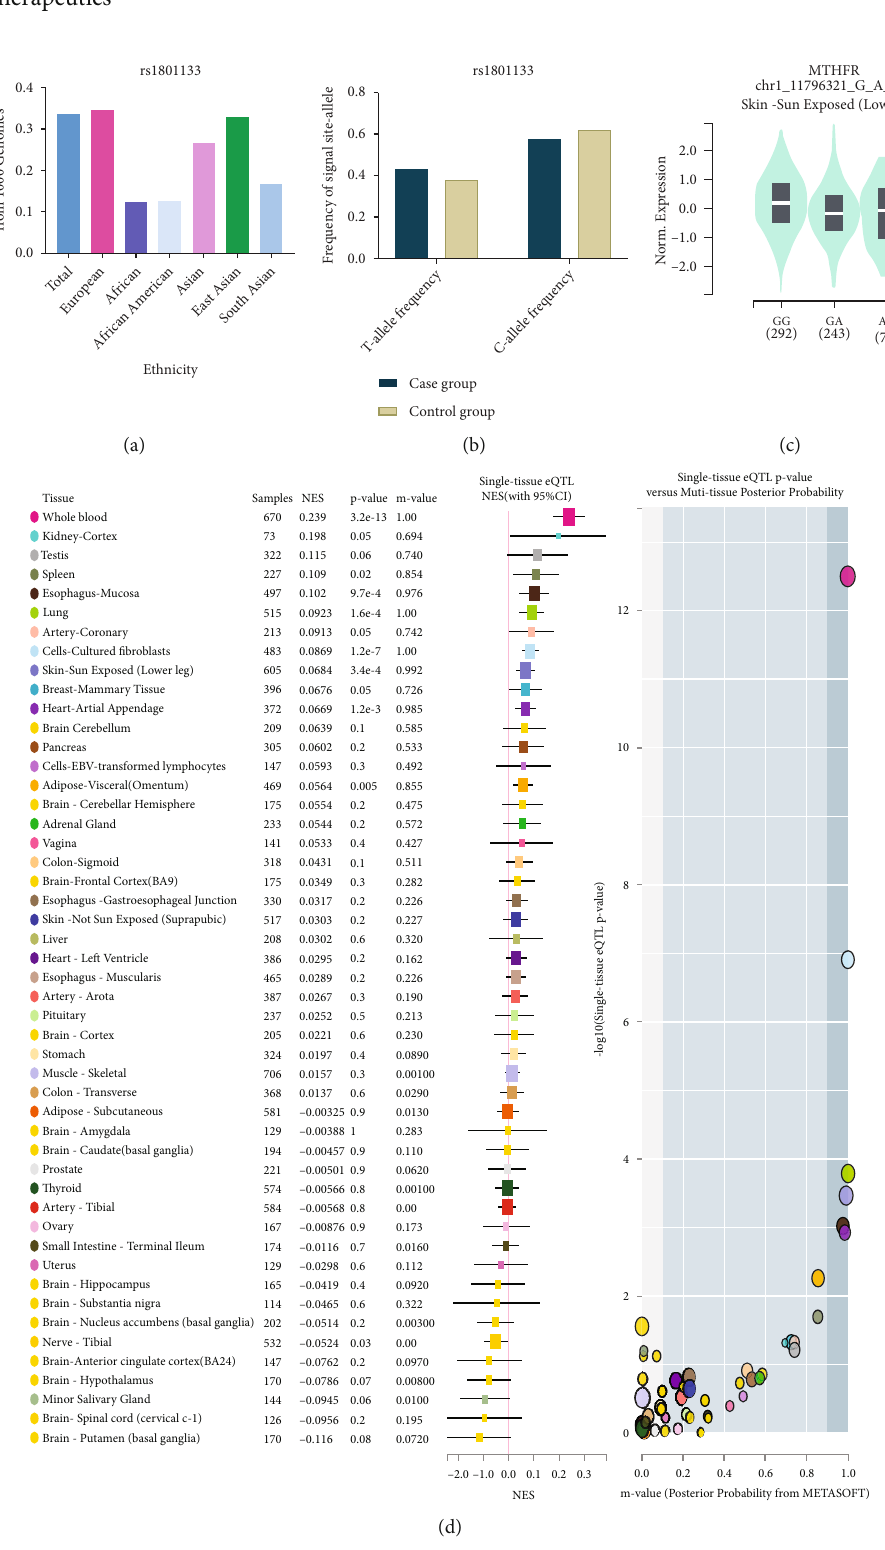
Figure 2: (a) The MAF of minor allele (mutant allele) for MTHFR gene rs1801133 polymorphism from the 1000 Genomes online database. (b) The frequency about T-allele or C-allele both in the case and control groups. (c) The distribution of each genotype from online GTEx Portal (https://www.gtexportal.org/home/). (d) The risk frequency of rs1801133 polymorphism to several diseases from TCGA